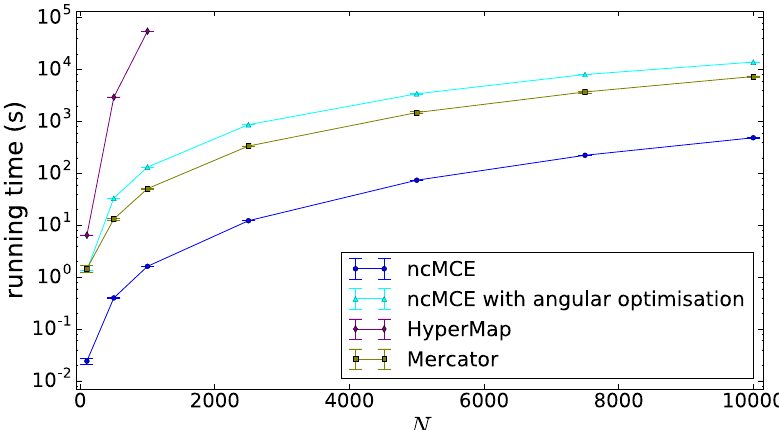
Figure 7. The running times of the studied embedding algorithms. The tests were run on synthetic networks obtained from the PSO model with ζ where 10 samples were generated at each N value. The measured average running time is shown in seconds, the bars indicate the 95% confidence